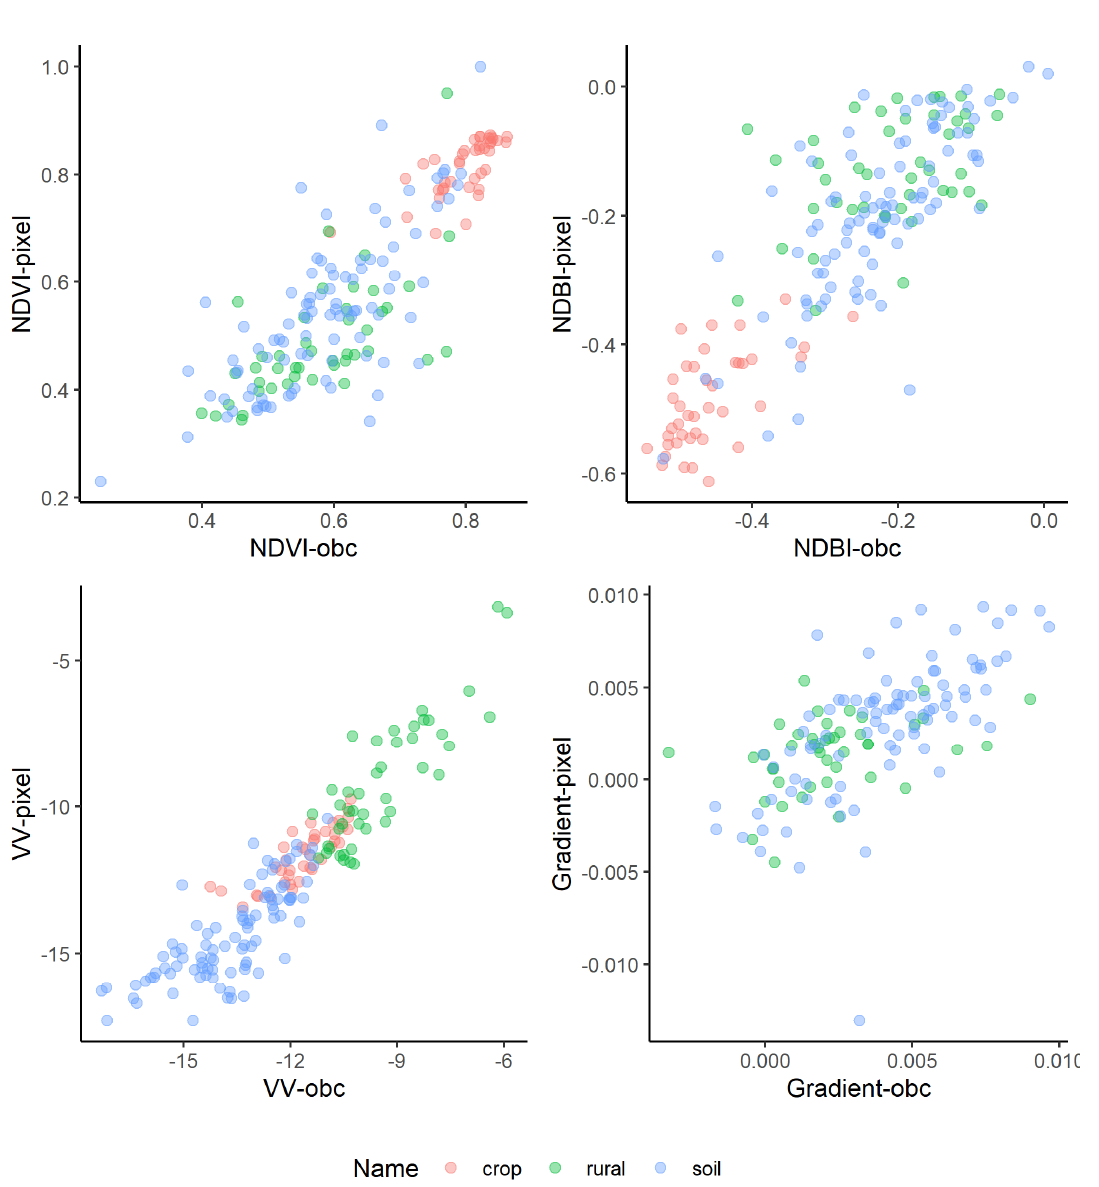
Figure 6. Scatter plot between pixel-and object- based features for three land cover types.